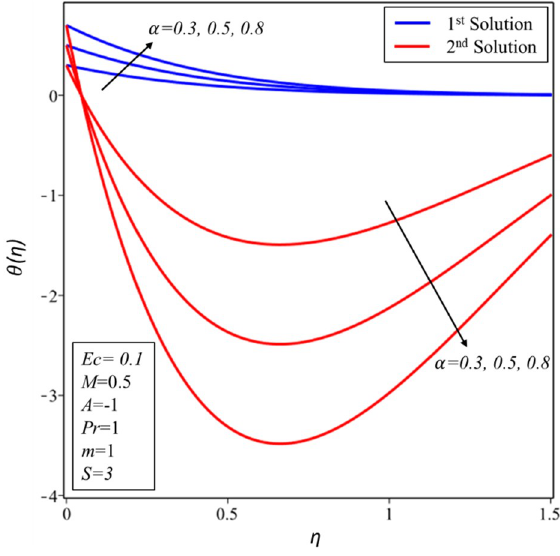
Figure 8. θ(η) for increasing values of α.